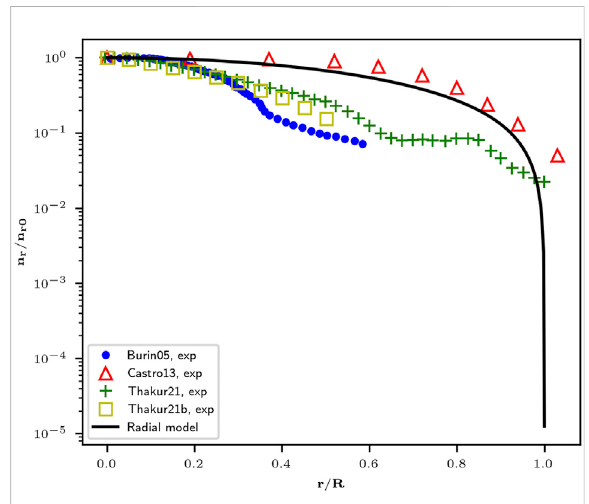
FIGURE 3 Comparison of the radial plasma density distribution estimated by Ahedo ’ s radial model [12, 20] and experimental data published by Burin et al. [21], Castro et al. [22], and Thakur et al. [5, 23].